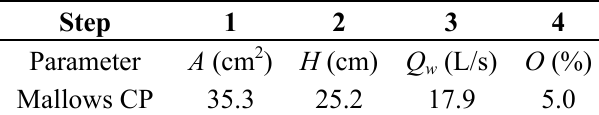
Table 2. Stepwise regression results for the four independent variables area of gate ( A ), head of water ( H ), opening percentage ( O ) and water discharge ( Q parameter of air flow rate ( Q a